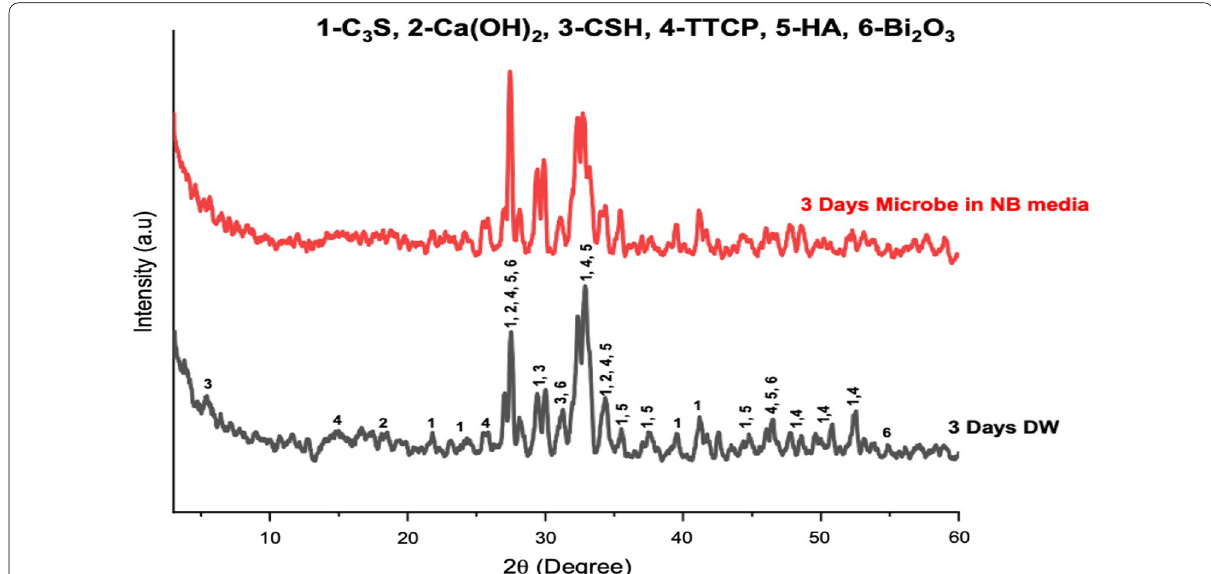
Fig. 7 X-ray diffraction patterns of 3-day sample cured in distilled water (DW) and Streptococcus thermophilus bacteria in nutrient broth NB media